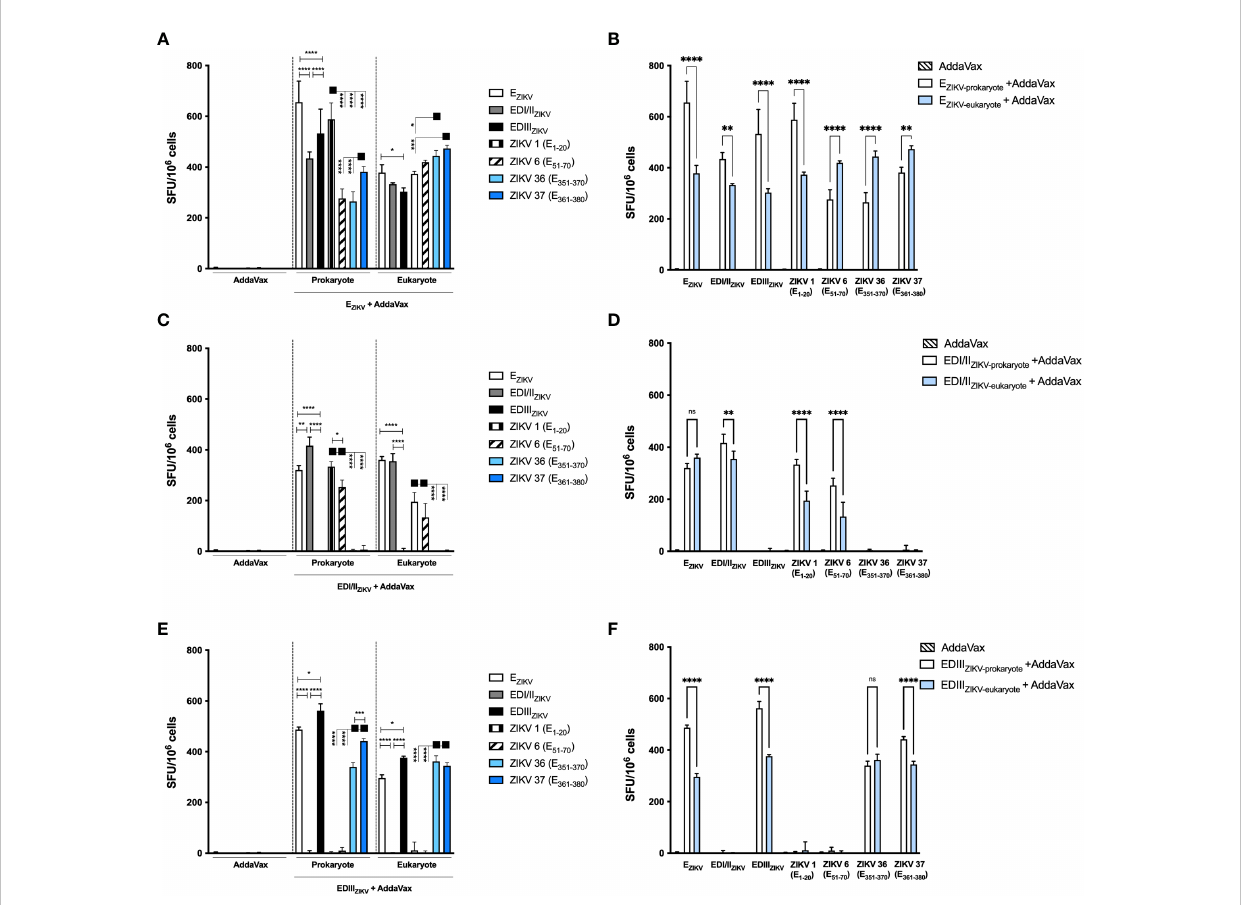
FIGURE 5 Speci fi c IFN g -producing cells after immunization with recombinant ZIKV antigens. Analysis of the speci fi c cellular immune responses after immunization of mice with antigens produced in bacterial or insect cells: (A, B) E ZIKV , (C, D) EDI/II ZIKV and (E, F) EDIII ZIKV . (B, D, F) Represents the head-to-head comparation between prokaryote and eukaryote proteins. Fifteen days after the boost the splenocytes were cultured in the presence of equimolar amount of recombinant proteins or ZIKV-speci fi c peptides for 18 hours to evaluate the number of IFN- g producing cells by ELISpot assay. SFU: spot forming units. Statistical signi fi cance was measured by Two-way ANOVA followed by Tukey ’ s post hoc test, *p < 0.05, **p < 0.01, ***p < 0.001, ****p < 0.0001, ns= not signi fi cant. Data represent mean ± SD and are representative of 3 independent